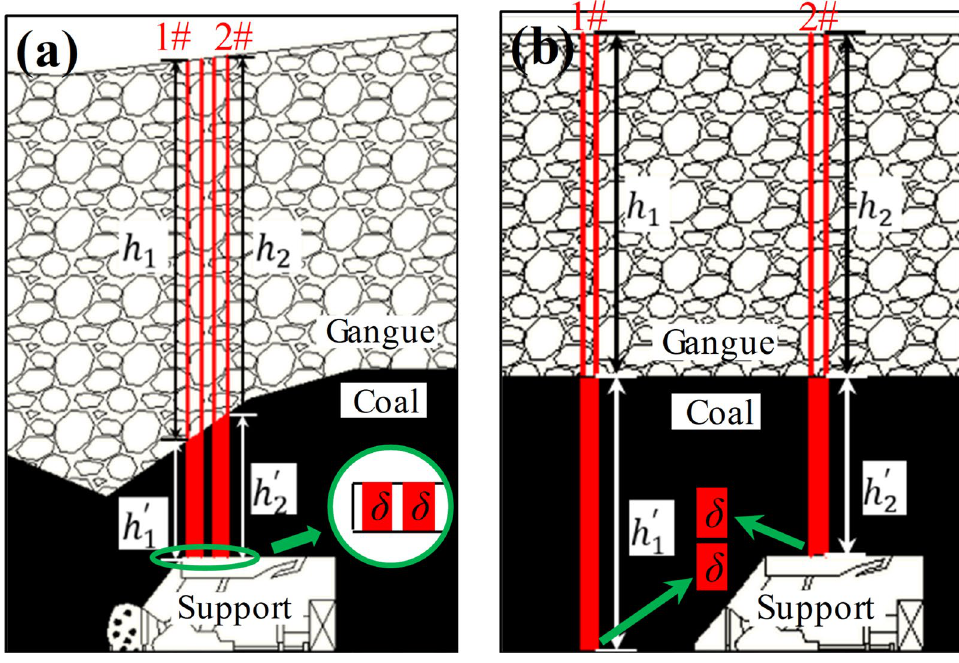
Fig. 3 Schematic diagrams of the gangue-coal column in the initial drawing stage: a During the drawing of top coal; b Before the drawing of top coal